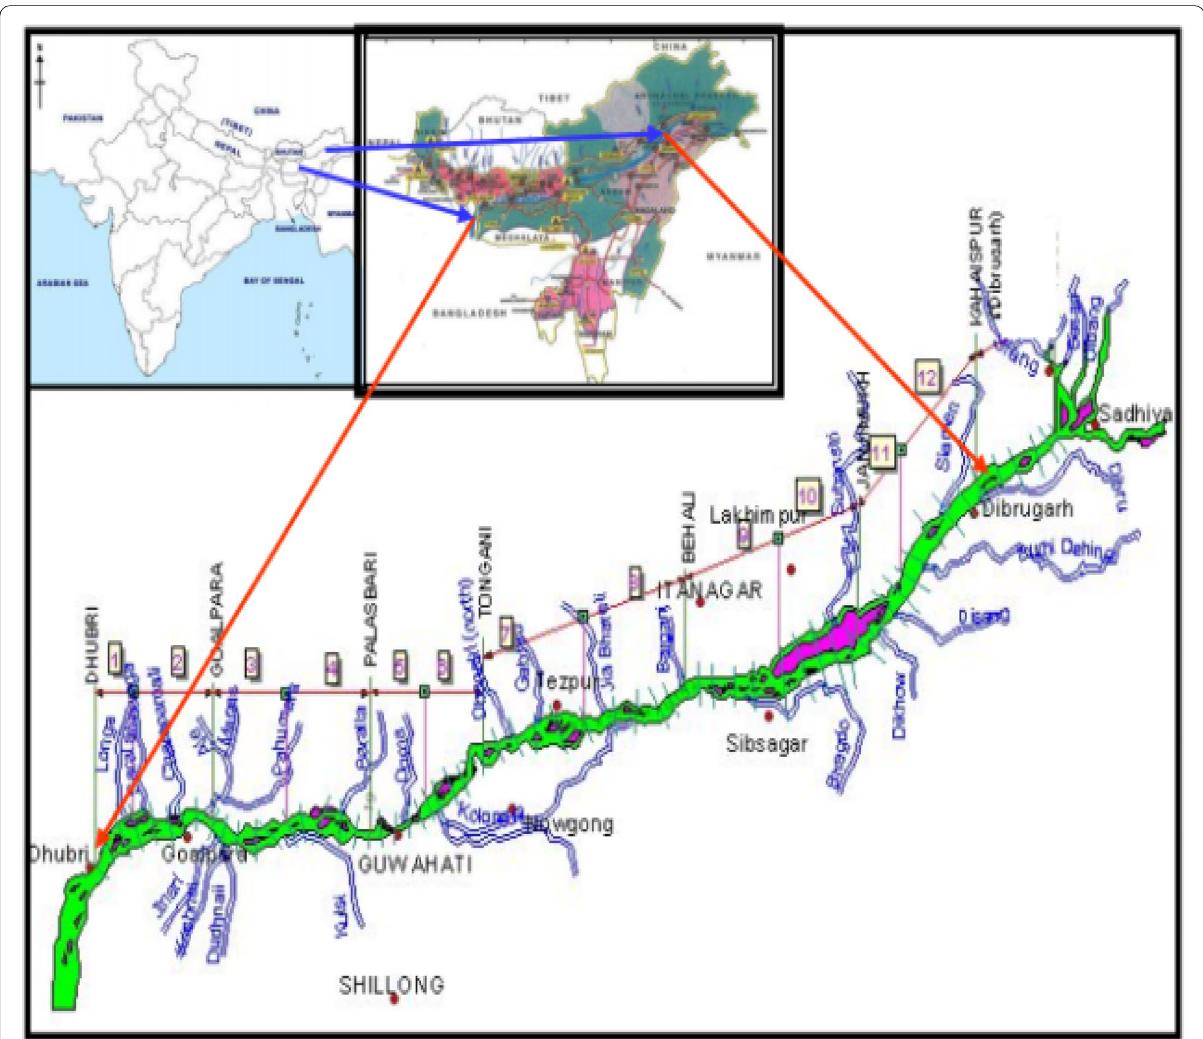
Fig. 1 Riverbank erosion Map of Brahmaputra River. 2013 Source: NDMA Commissioned IIT Roorkee Study on Brahmaputra River Erosion: A Biased and Structural Solution Oriented